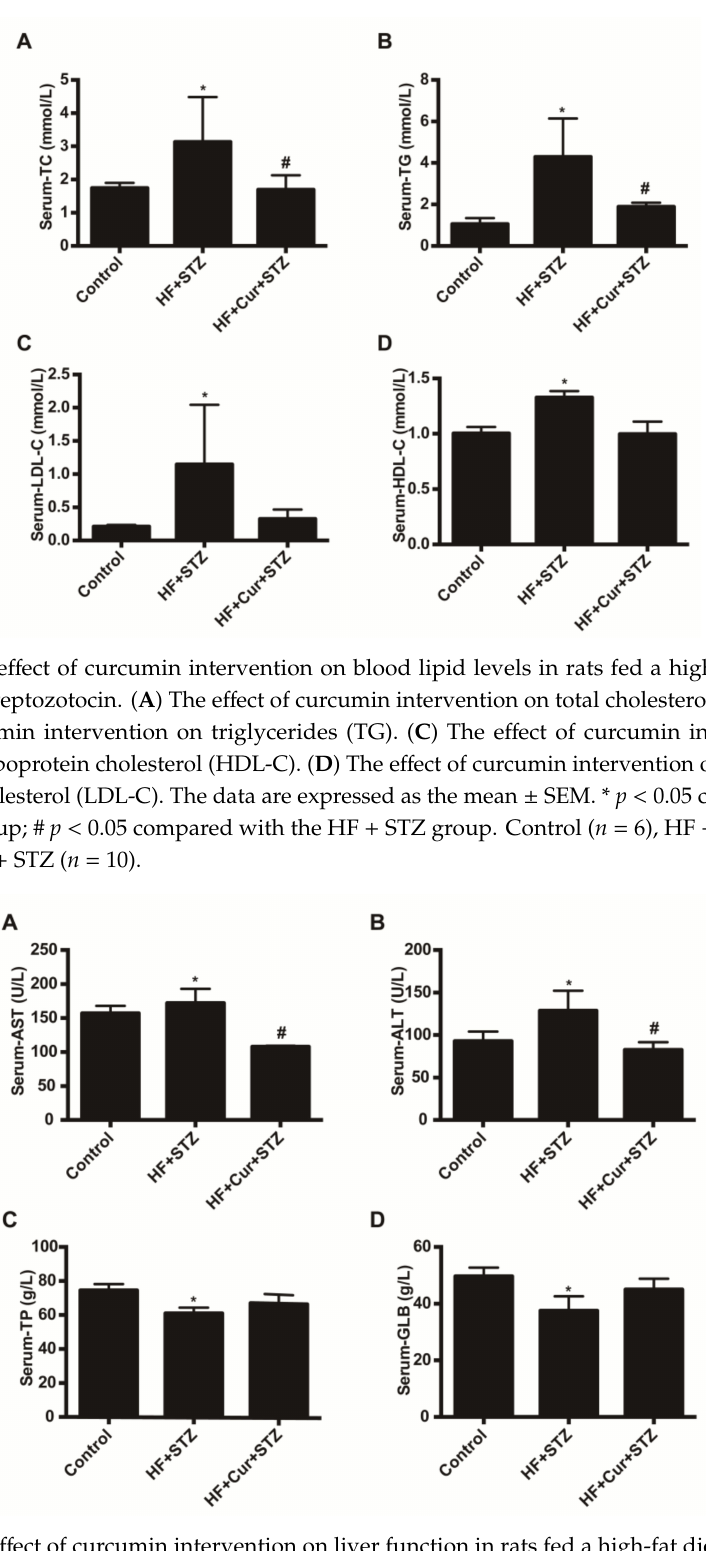
Figure 5. The e ff ect of curcumin intervention on liver function in rats fed a high-fat diet then treated with streptozotocin. ( A ) The e ff ect of curcumin intervention on aspartate aminotransferase. ( B ) The e ff ect of curcumin intervention on alanine aminotransferase. ( C ) The e ff ect of curcumin intervention on total protein. ( D ) The e ff ect of curcumin intervention on globulin. The data are expressed as the mean ± SEM. * p < 0.05 compared with the control group; # p < 0.05 compared with the HF + STZ group. Control ( n = 6), HF + STZ ( n = 10), and HF + Cur + STZ ( n =